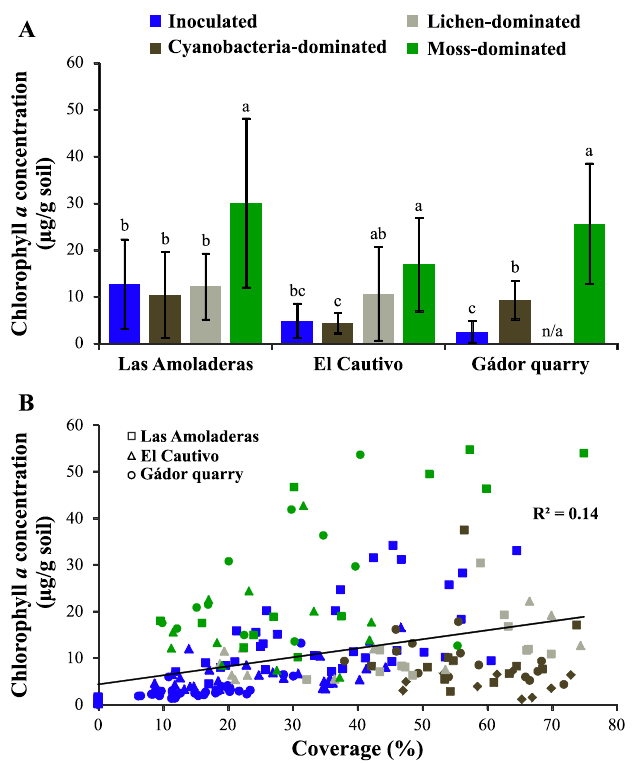
Figure 2. ( A ) Mean (± SD) of the chlorophyll a concentration (µg/g soil) in different crust types in Las Amoladeras, El Cautivo, and Gádor quarry study sites. ( B ) Linear regression of the chlorophyll a Amoladeras, El Cautivo, and G á dor quarry study sites. ( B ) Linear regression of the chlorophyll a concentration and biocrust coverage (%). concentration and biocrust coverage